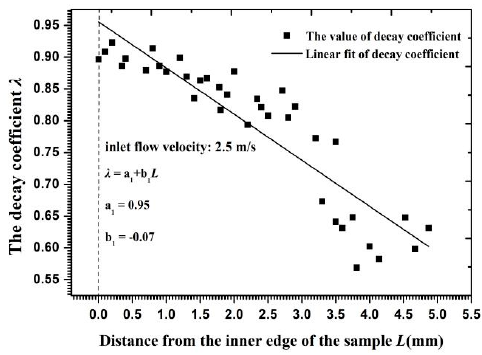
Figure 15. The velocity decay coefficient in collision versus the distance from the inner edge.